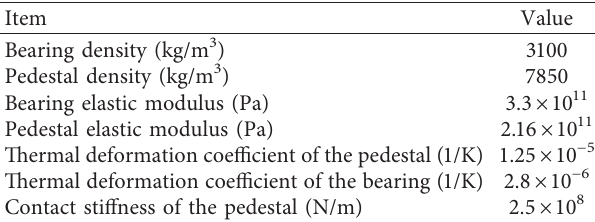
Table 2: Physical parameters of the bearing